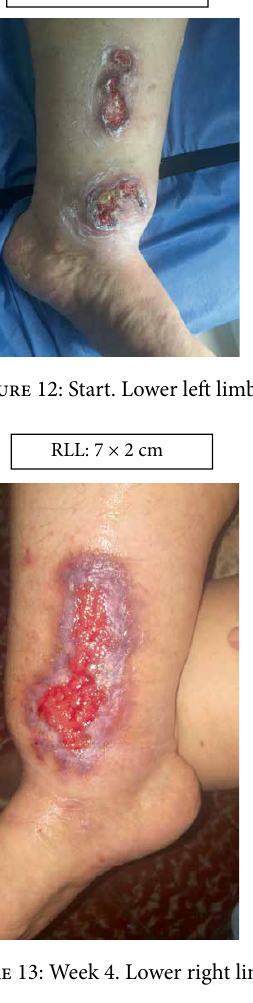
Figure 16: Week 9. Lower left